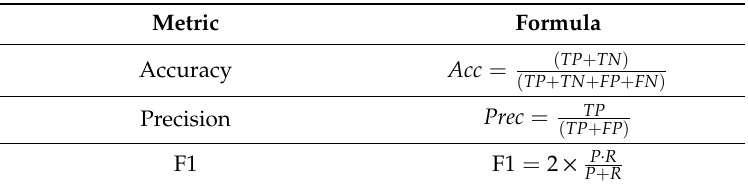
Table 2. Metrics.